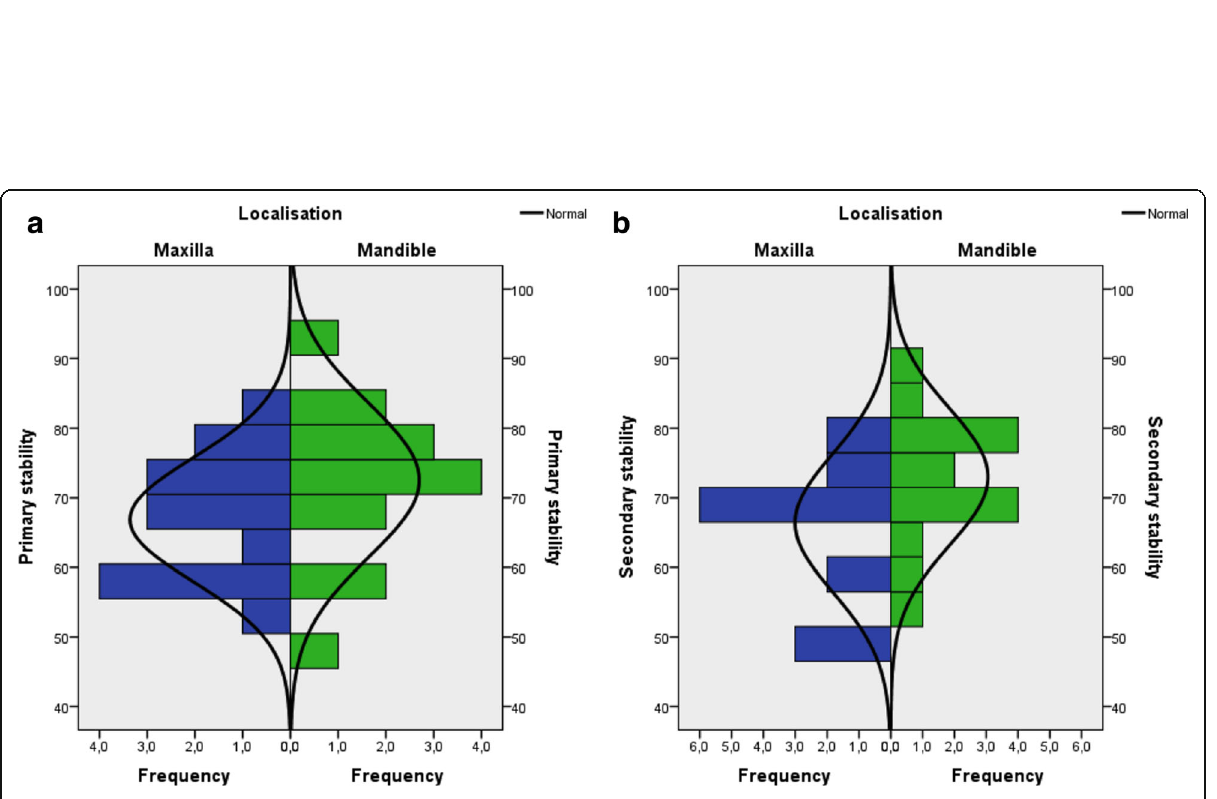
Fig. 3 a Primary implant stability. The histogram visualises the distribution of the implant stability quotients (ISQ) for both jaws measured by resonance frequency analysis (Osstell AB, Göteborg, Sweden). b Secondary implant stability. The histogram shows the distribution of the implant stability quotients (ISQ) of osseointegrated implants. According to the measurement implant stability was classified as low with ISQ values < 60, medium with ISQ values 60 – 70, and high with values ISQ > 70